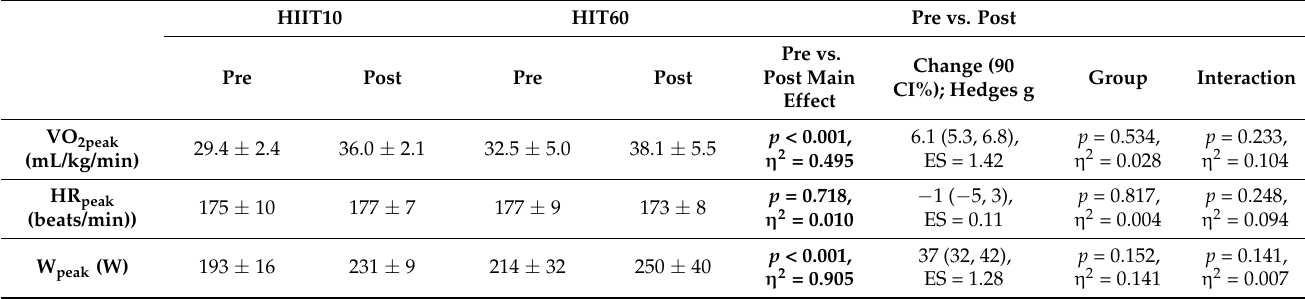
Values are means ± standard deviation. Bold font highlights statistically significant differences. 90% CI, 90% confidence interval; η 2 , partial eta squared; ES, effect size; HR peak , peak heart rate; VO 2peak , peak oxygen uptake; W peak , peak